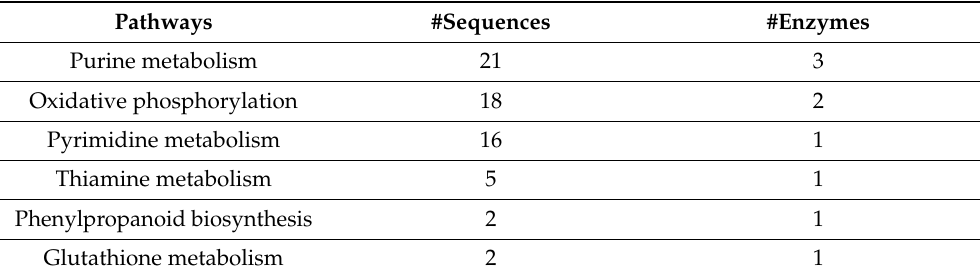
Table 1. Description of activated pathways after biostimulant application.